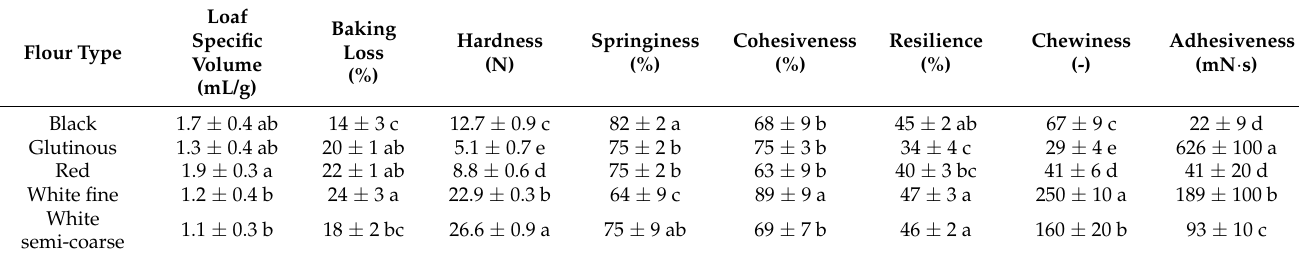
Figure 2. Crumb of bread prepared from ( a ) black rice; ( b ) glutinous rice; ( c ) red rice; ( d ) refined white fine; ( e ) refined white semi-coarse flour. Table 4. Textural characteristics of breads prepared from different rice flours 4